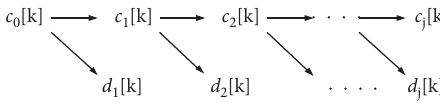
Figure 1: Diagram of Mallat